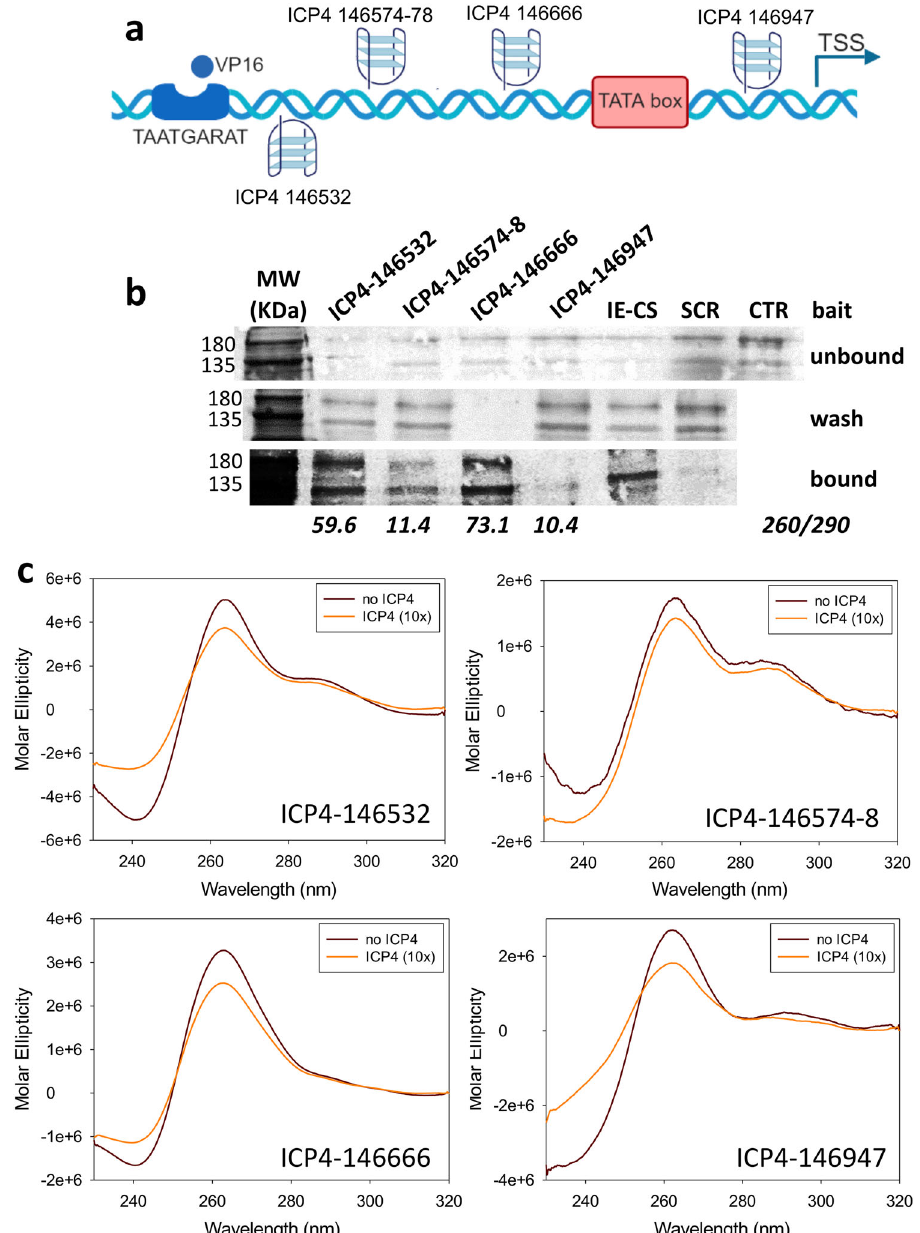
Fig. 3 ICP4 binding and unfolding of G4 sequences embedded in the ICP4 promoter. a Schematic representation of G4s present in the ICP4 promoter. Each G4 is indicated with the name of the oligo used in the study. The TAATGARAT region is shown as a blue box with the VP16 protein nearby; the TATA box is represented as a red box; the arrow indicates the position of the Transcriptional Start Site (TSS). The position of each of these features on the double helix with respect to the TSS is on scale. The G4s are shown according to the DNA strand in which they are embedded. b Western blot analysis of ICP4 cross-linking pull-down towards the indicated four G4s embedded in the ICP4 promoter. IE-CS is the reported ICP4 consensus sequence 42, 60, 61 ; SCR is a G-rich unfolded oligo; CTR is a control lane loaded with infected cell nuclear extracts not subjected to the pull-down procedure. MW: molecular weight (Marker VI, Applichem). The upper panel shows the unbound ICP4 fraction, the middle panel the washed out ICP4 fraction, the lower panel the ICP4 fraction bound to each oligo. The multiband appearance of ICP4 from HSV-1 infected cells in WB has been reported 91 and re fl ects the presence of differently post-transcriptionally processed isoforms. The experiment was independently performed in duplicate. Each replicate was tested once in each experiment. c CD spectra of the indicated G4 sequences embedded in the ICP4 promoter folded in potassium phosphate buffer (20 mM PB, 2 mM KCl) and incubated in the absence/presence of ufICP4 (10x). ICP4 spectrum was subtracted from G4-ICP4 complex spectra. Two independent experiment encompassing one replicate per condition were performed. Representative spectra form one measurement are